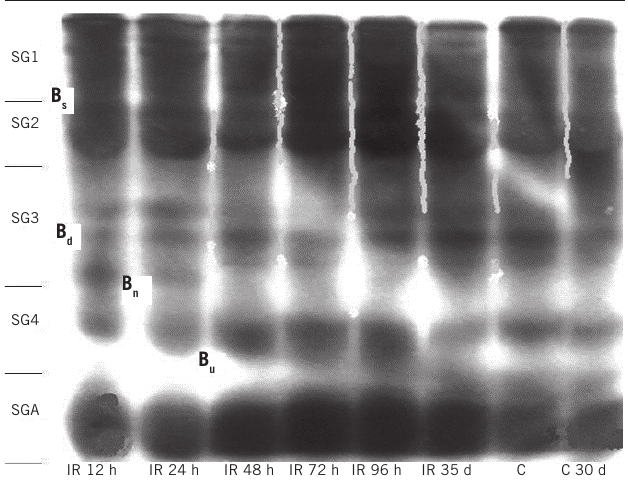
IR 12 figurE 1 − Electrophoretic profile at 10%, blood serum in cardiac territory of IR and C on days 0 and 30, in kinetics of 12, 24, 48, 72, and 96 h, and 35 days, identified in SG1, SG2, SG3, SG4, and SGA IR: irradiated animals; C: control group; SG1: subgroup 1; SG2: subgroup 2; SG3: subgroup 3; SG4: subgroup 4; SGA: subgroup albumin.